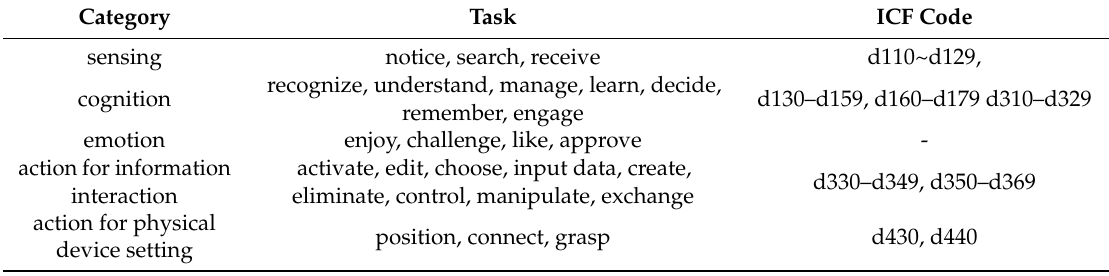
Table 3. An IT device task taxonomy.